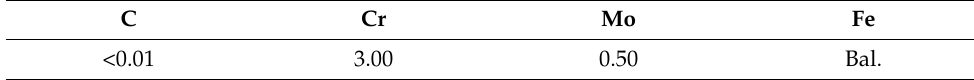
Table 1. Chemical composition of the Astaloy CrM powders [%wt].